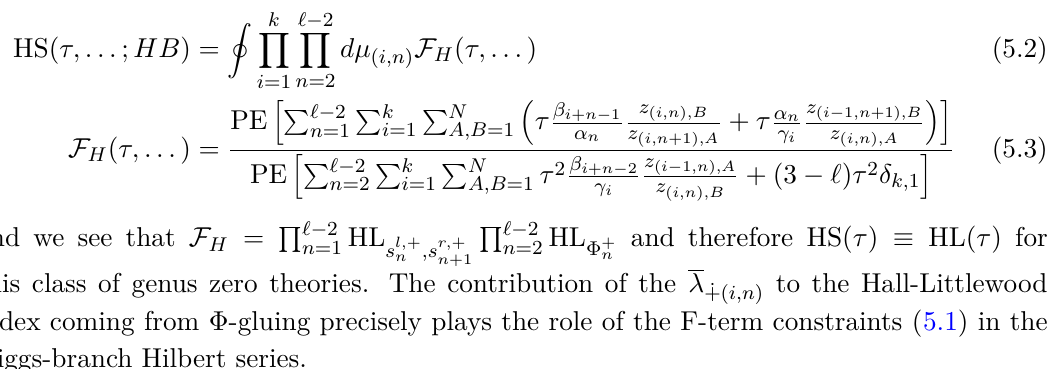
Figure 5. Branching of with given j index